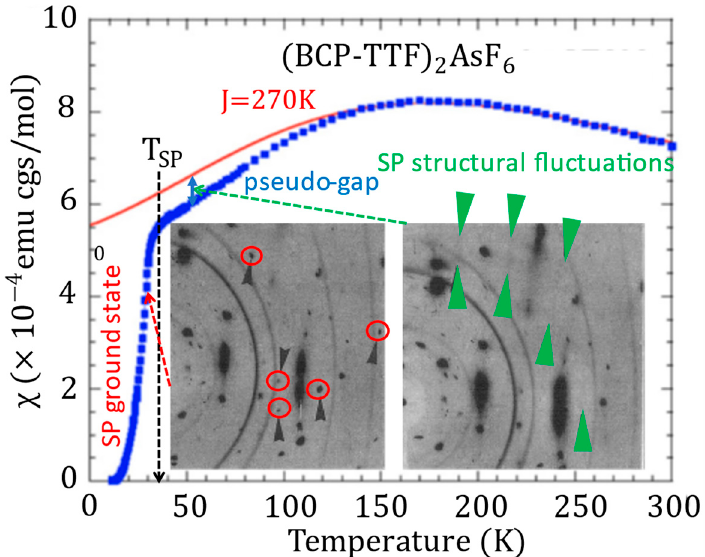
Figure 4. Spin susceptibility of (BCP-TTF) 2 AsF 6 , showing the development of a pseudo-gap below T MF ≈ 120𝐾 when quasi-1D SP fluctuations of chain dimerization develop. Spin susceptibility abruptly drops at the T SP = 35 K SP phase transition, below which satellite reflections due to the dimerization are detected. The inset presents the PF 6 salt X-ray diffuse scattering patterns taken (right part) in the regime of quasi-1D SP fluctuations (green arrows), and (left part) in the 3D-SP dimerized phase (superlattice reflections surrounded by red circles). The figure combines results taken from refs. [18,31].